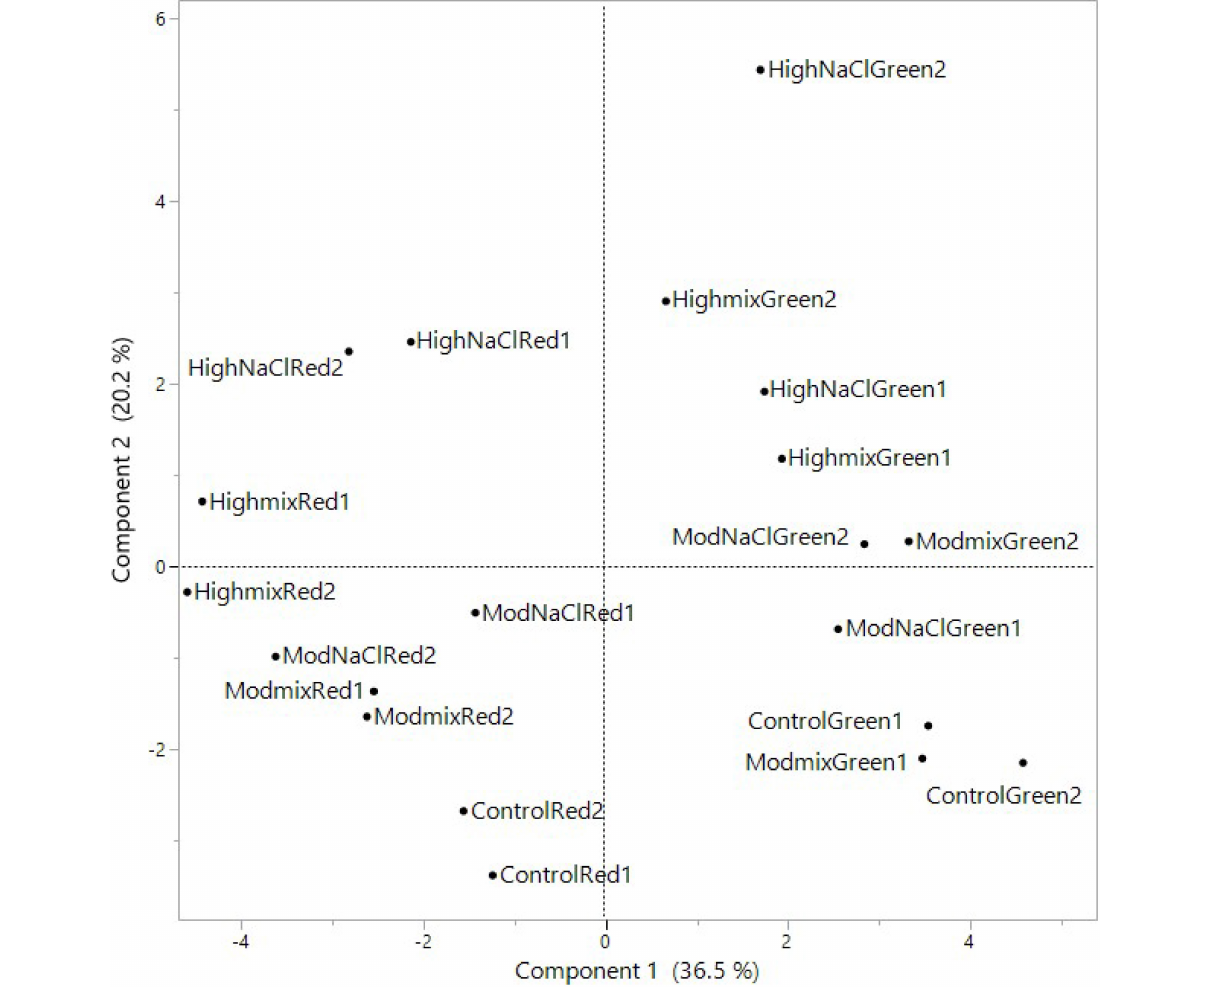
FIGURE 2 | Scores of PCA of morphometric and yield parameters, nutritional quality, aromatic profile, leaf colorimetry and macronutrient concentration of Green and Red cultivars grown hydroponically under iso-osmotic salinity treatments and harvested in two sequential cuts. Salinity treatments: Control = non-salt; Moderate Mix = (12.5 mM NaCl + 8.3 mM CaCl 2 ); Moderate NaCl = 25 mM NaCl; High Mix = (25 mM NaCl + 16.6 mM CaCl 2 ); High NaCl = 50 mM